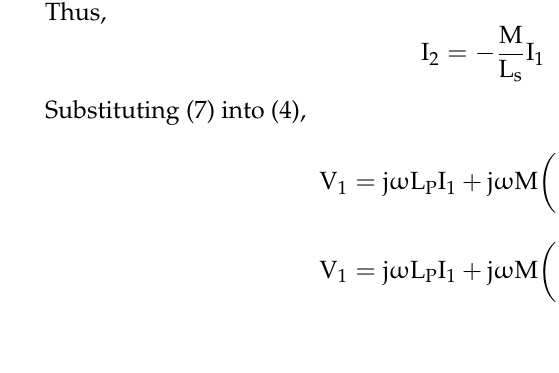
Figure 10. Simple analysis schematic for the TVB operation.